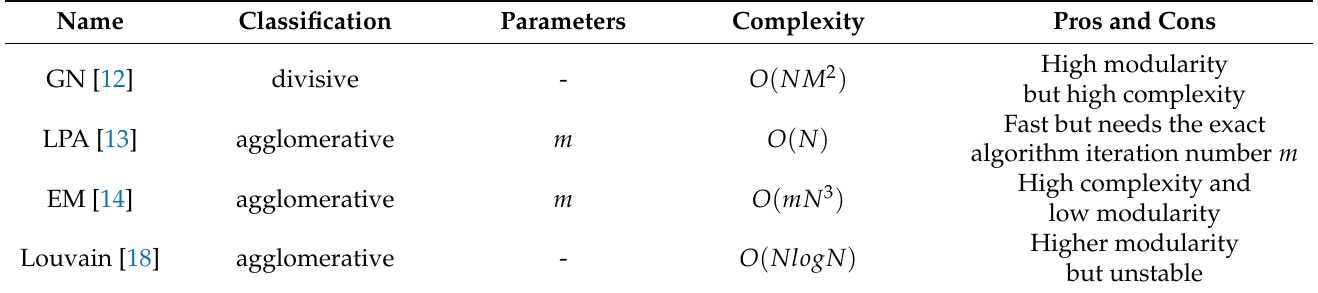
Table 1. Comparison of some classic community detection